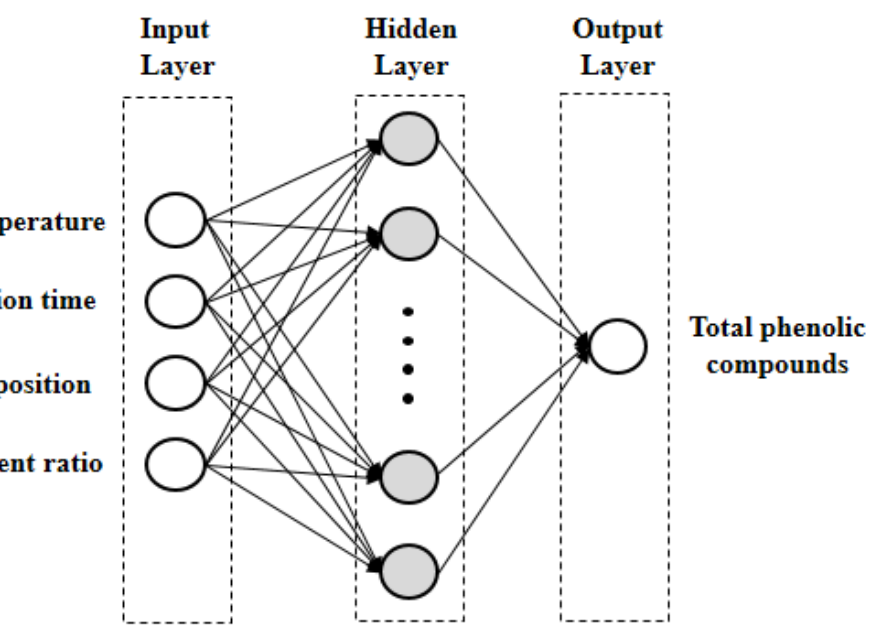
Figure 1. Artificial neural network architecture.